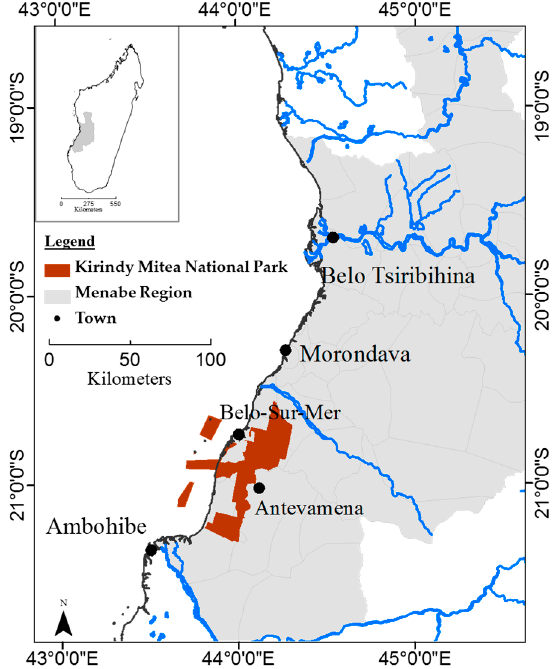
Figure 1. Menabe Region highlighting the location of Kirindy Mitea National Park.